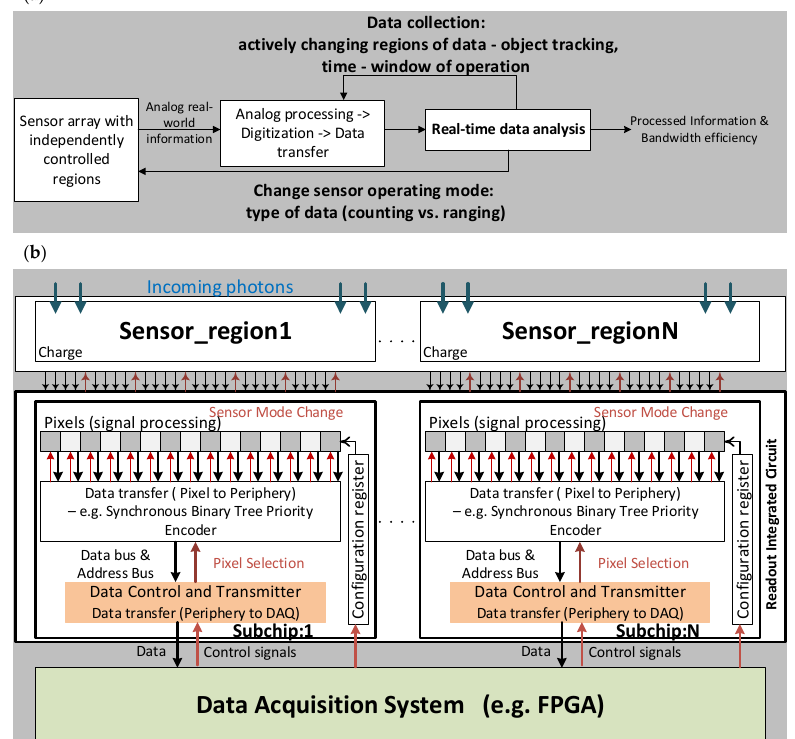
Figure 2. ( a ) Conceptual view of data flow. ( b ) System consisting of a sensor bonded to a ROIC with several independent, individually programmable subchips. Each subchip contains a peripheral data controller and transmitter (DCT). The DCT performs three critical functions, firstly it controls a synchronized binary tree priority encoder to transfer data from pixel to periphery, secondly it controls the output serializer to send data off-chip to an FPGA and thirdly it is also capable of being dynamically reconfigured by the FPGA in real-time. Data transfer is indicated with black arrows and control signals with red